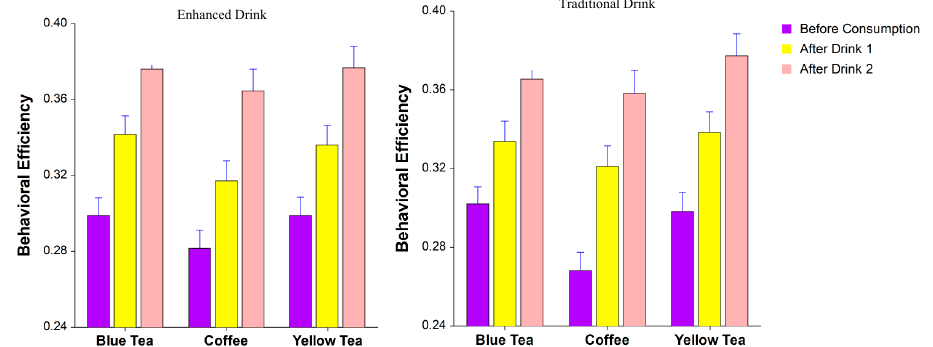
Figure 4. Math behavioral efficiency. The left graph indicates behavioral efficiency while participants consumed the enhanced drink. The right graph indicates behavioral efficiency while participants consumed the traditional drink. Whiskers represent the SEM.